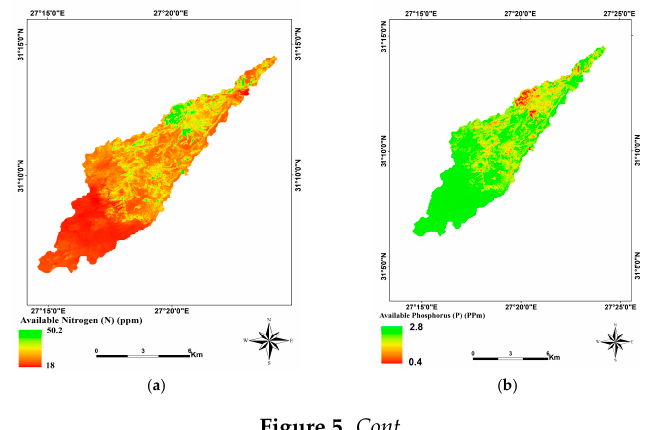
13 of 21 ( e ) Figure 5. Spatial distribution of predicted soil properties using OLI satellite images: ( a ) nitrogen (N); ( b ) phosphorus (P); ( c ) potassium (K); ( d ) pH; and ( e ) SOM. 3.6. Soil Fertility Status of Wadi El-Garawla Spatial distribution maps resulting from spectral measurements of soil nutrients were more significant than those produced using satellite imagery. Therefore, fertility status in the study area was evaluated using spectroscopic measurements directly as performed through the spatial modeling of all characteristics. Figure 6 shows the spatial distribution of the status fertility of the study area depending on the integration of available N, P, and K, the SOM, and the pH. Three degrees of soil fertility were recognized in the study area, namely high, moderate, and low. Their respective area of coverage was 1019.136 ha (about 16% of the total study area), 2709.02 ha (43%), and 2536.9 ha (41%). Figure 5. Spatial distribution of predicted soil properties using OLI satellite images: ( a ) nitrogen (N); ( b ) phosphorus (P); ( c ) potassium (K); ( d ) pH; and ( e ) SOM.